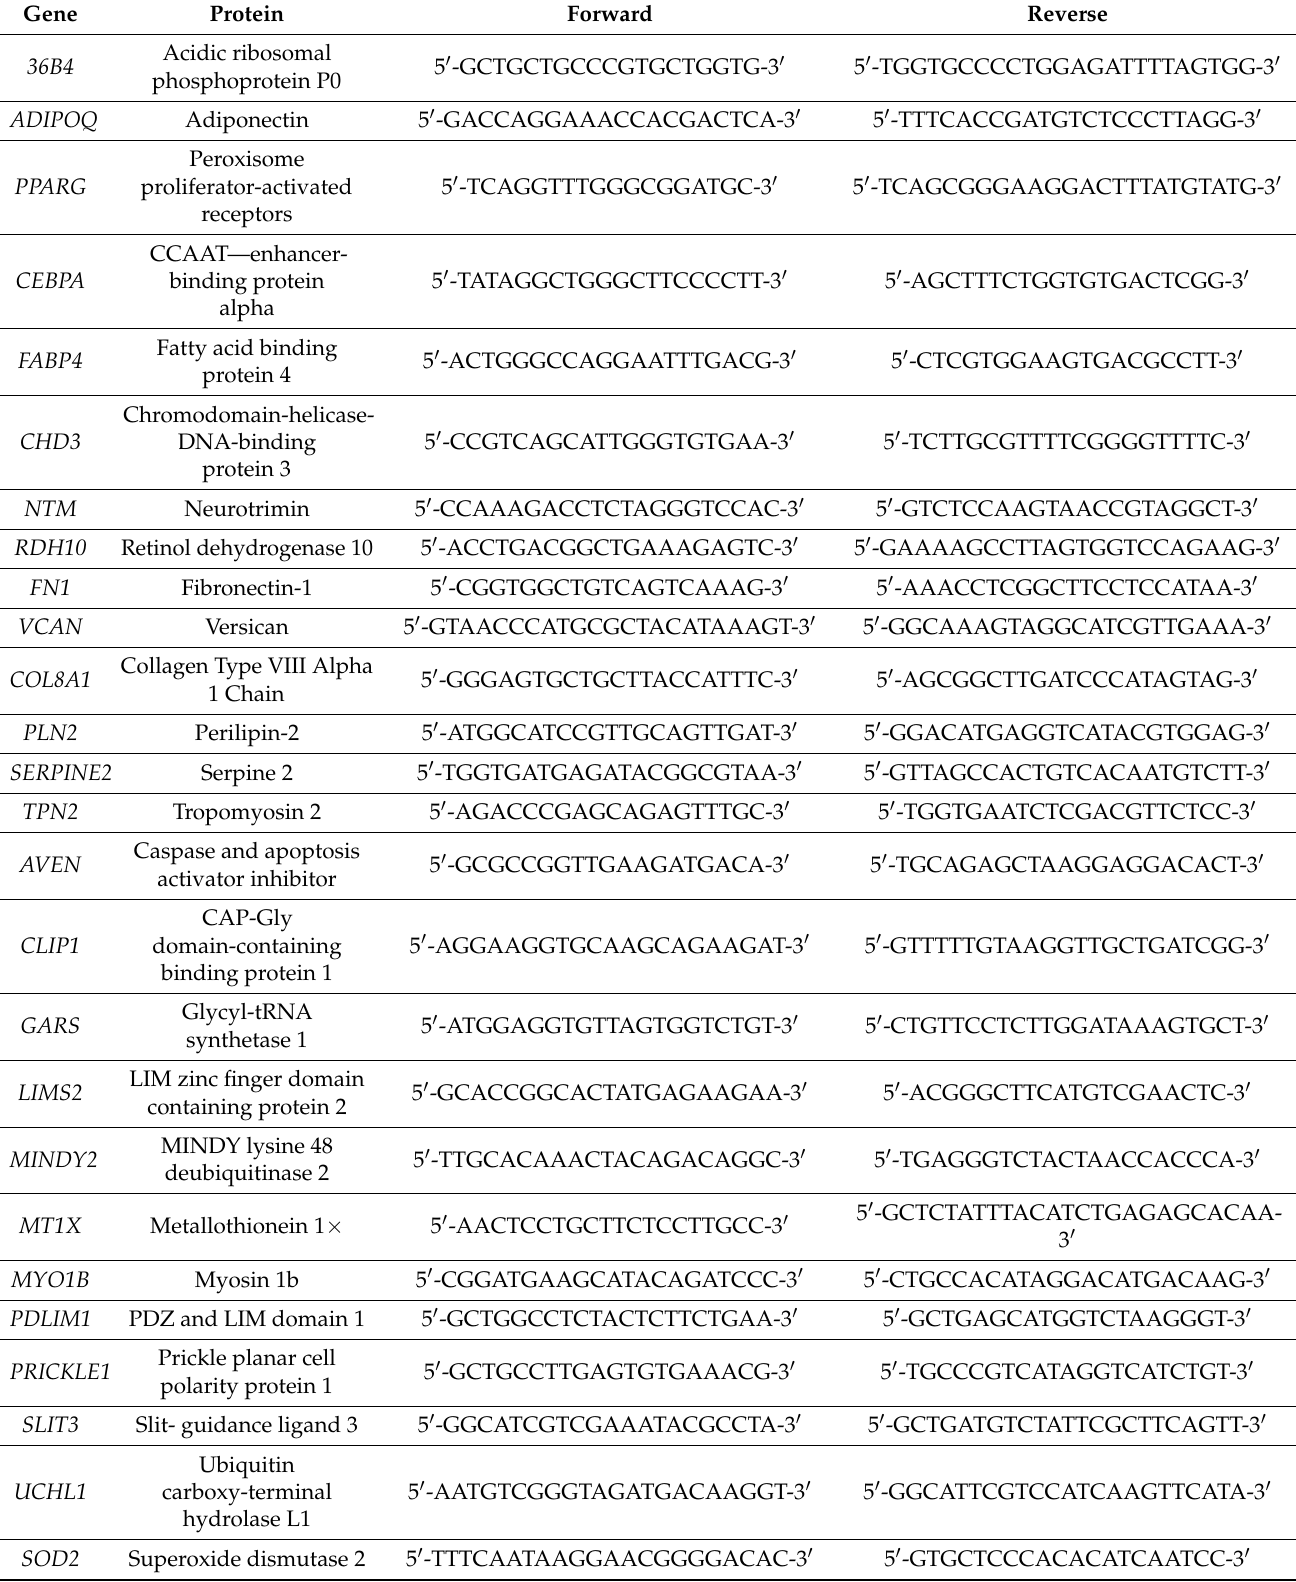
Table 1. Primer pairs used for the qRT-PCR and the respective gene